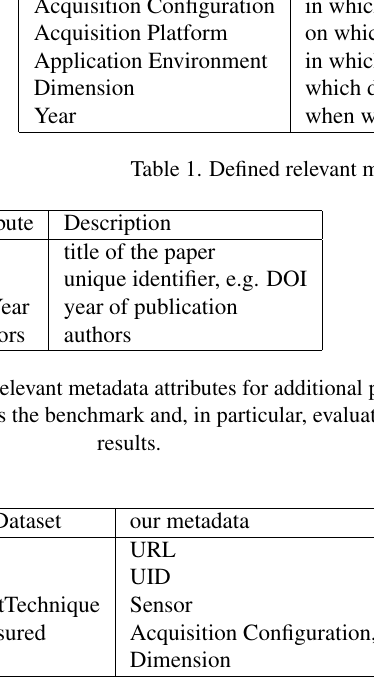
Table 3. Correspondences between schema.org dataset and our metadata.